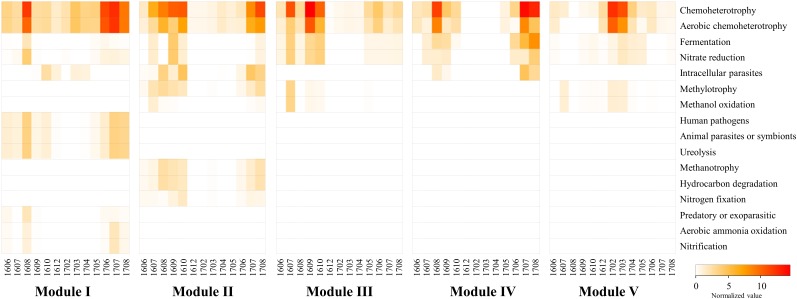
The heatmap showing the distribution of the functional groups of prokaryotic communities of modules using FAPROTAX. The normalized value was calculated by multiplying the calculated values (“function tables”) by the total sum of the OTUs belonging to each major module. Samples are labeled by a four-number code indicating the year and month of sampling (in YYMM format).